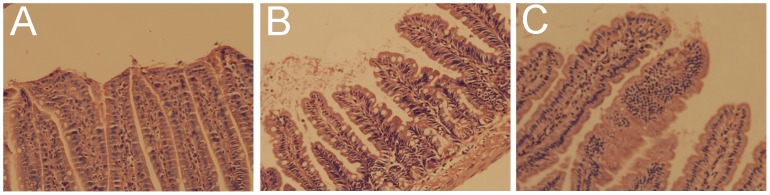
The therapeutic effect of Ad-hITF on burn-induced intestinal lesions.Ad-hITF or saline was given orally to the mice inflicted with thermal injury. The mice were sacrificed on PBD3. (A) Normal intestinal mucosa in the C group (hematoxylin and eosin [HE], ×200). (B) Representative mouse intestine treated with saline. Note that extensive necrotic lesions can be seen in the corpus. Diffusely severe hemorrhagic and necrotic mucosa were confirmed using histological examination (HE, ×200). (C) Representative mouse intestine in animals receiving Ad-hITF therapy. No necrosis is noted except for diffuse edema; microscopic examination demonstrated that the superficial epithelium was intact (HE, ×200).